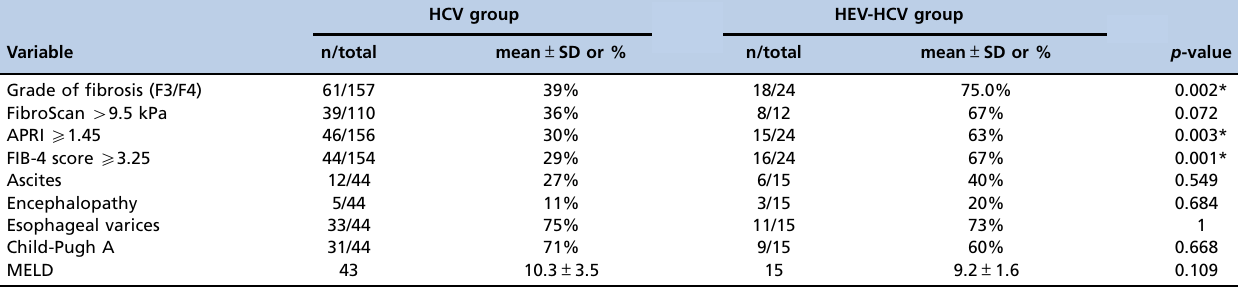
Table 4 - Comparison of HEV-HCV patients and HCV mono-infected patients regarding liver disease